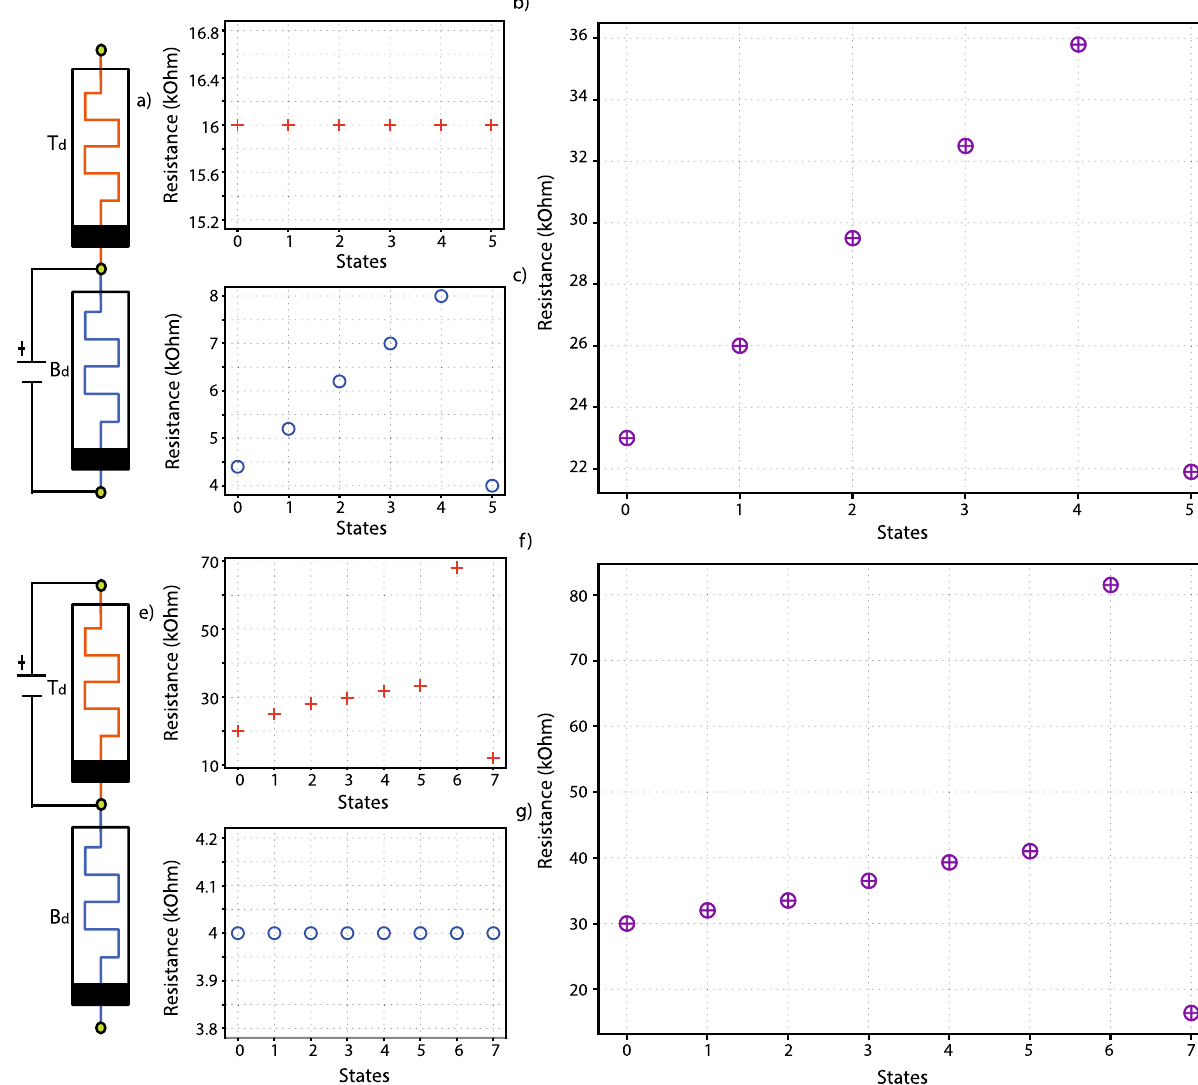
Figure 2. Complete device switching when the Bottom device is switched ( a – d ) and when the Top device (Td) is switched ( e – h ). Subfigures ( a , e ) depict the equivalent circuit during programming, where the switching and non-switching components can be distinguished. Subfigures ( b , c , f , g ) show the corresponding states of the devices in each step of the experiment, with ( b , c ) corresponding to the Top and Bottom devices of subfigure ( a ), while ( f , g ) correspond to the respective devices in subfigure ( e ). Evidence from ( b , g ) shows that the secondary device remains stable, while the switching device is being programmed in ( c , f ) respectively. Subfigures ( d , h ) result from measuring the resistive state of the Complete devices ( a , e ). In both cases it is evident that Complete device resistive states follow the curve set by the switching device, but the relation is not simply additive, due to the Complete device functioning as a voltage divider, thus slightly offsetting the effective voltage received by individual devices. (in both cases a change of XΩ in the switching device leads to a change Y > XΩ at the